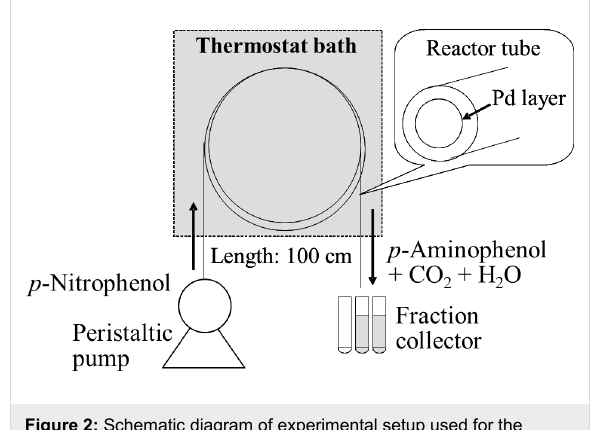
Figure 2: Schematic diagram of experimental setup used for the catalytic hydrogenation of p -nitrophenol.